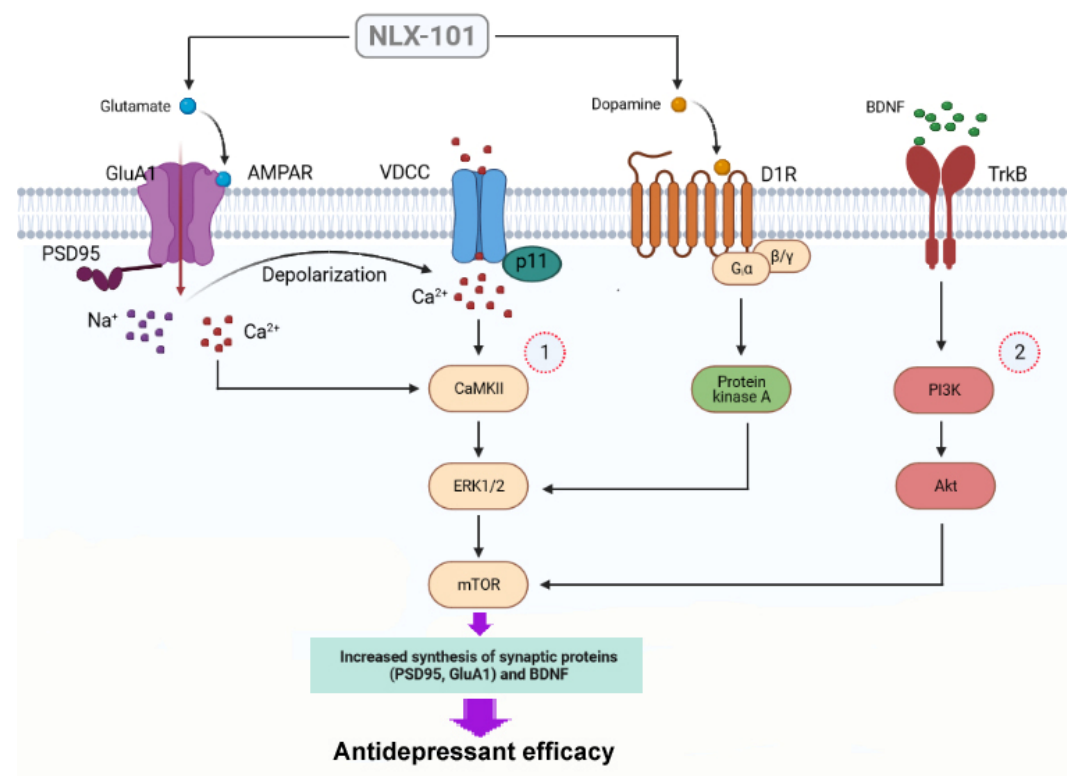
Figure 8. Scheme of the intracellular signaling pathways involved in the antidepressant-like effects of NLX-101. NLX-101 preferentially activates 5-HT 1A receptors expressed in GABA interneurons, thus reducing their activity and inducing a disinhibition of glutamatergic neurons with the subsequent release of glutamate and dopamine. Glutamate would evoke a rapid (1) stimulation of AMPA receptors (AMPAR) localized to the plasma membrane of pyramidal cells, which would result in a rapid intracellular activation of CaMKII that would eventually activate (phosphorylate) ERK1/2 and mTOR pathways, thus inducing a rapid synthesis of PSD95 and p11. The binding of dopamine to D1 receptors (D1R) can also contribute to the expression of ERK1/2 through activation of protein kinase A. A delayed antidepressant mechanism (2) would involve the mTOR-induced synthesis of BDNF that would bind to its receptor, TrkB, followed by downstream activation of Akt and synthesis of GluA1. Abbreviations: AMPA, α -amino-3-hydroxy-5-methyl-4-isoxazolepropionic acid; BDNF, brain-derived neurotrophic factor; CaMKII, Ca 2+ /calmodulin-dependent protein kinase II; D1, dopamine D1 receptor; ERK1/2, extracellular-regulated kinase 1/2; mTOR, mammalian target of rapamycin; PI3K, phosphatidylinositol-3 kinase; TrkB, tropomyosin receptor kinase B; VDCC, voltage-dependent calcium channel. Illustration created with BioRender.com, accessed on 26 January 2022.